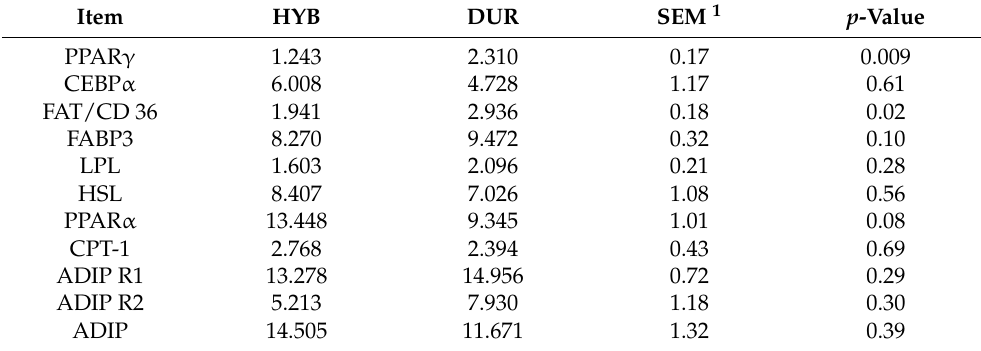
Table 10. mRNA expression in SM muscle of pigs of different genetic